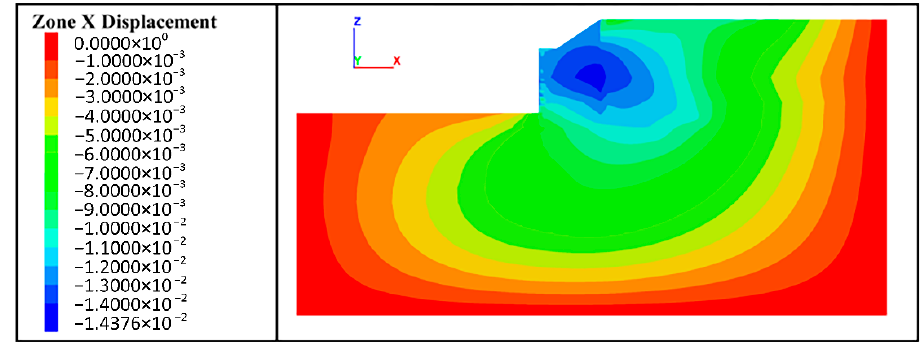
Figure 21. Final horizontal displacement cloud image.